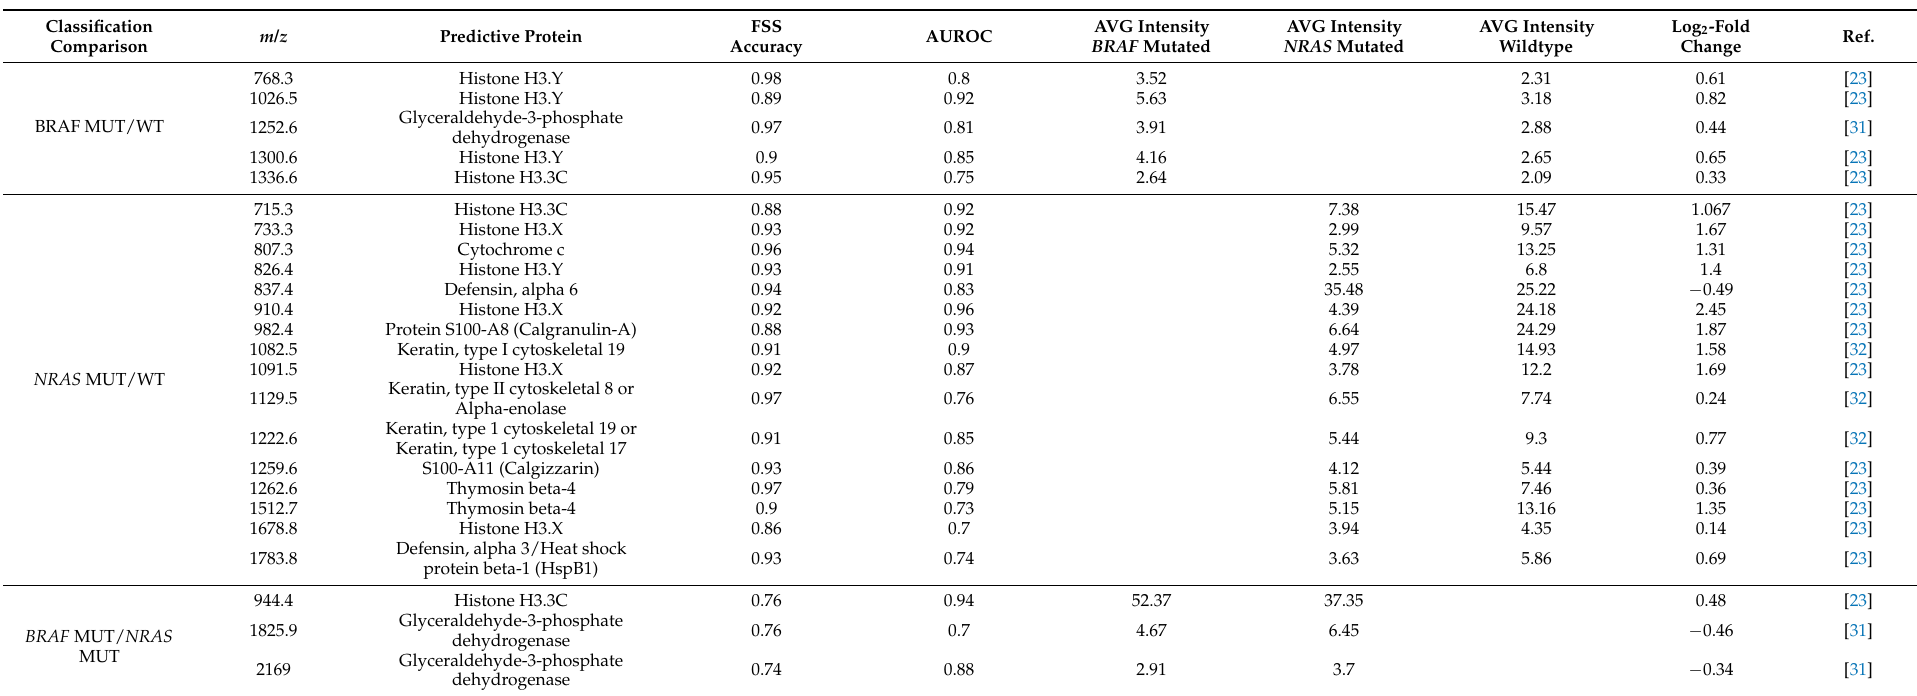
Table 7. List of the major m / z peak discriminators selected by forward feature selection (FFS). Tentative identification of proteins between NRAS (neuroblastoma RAS viral oncogene homolog) mutated and NRAS WT, between BRAF (v-raf murine sarcoma viral oncogene homolog B1) mutated and BRAF WT, and